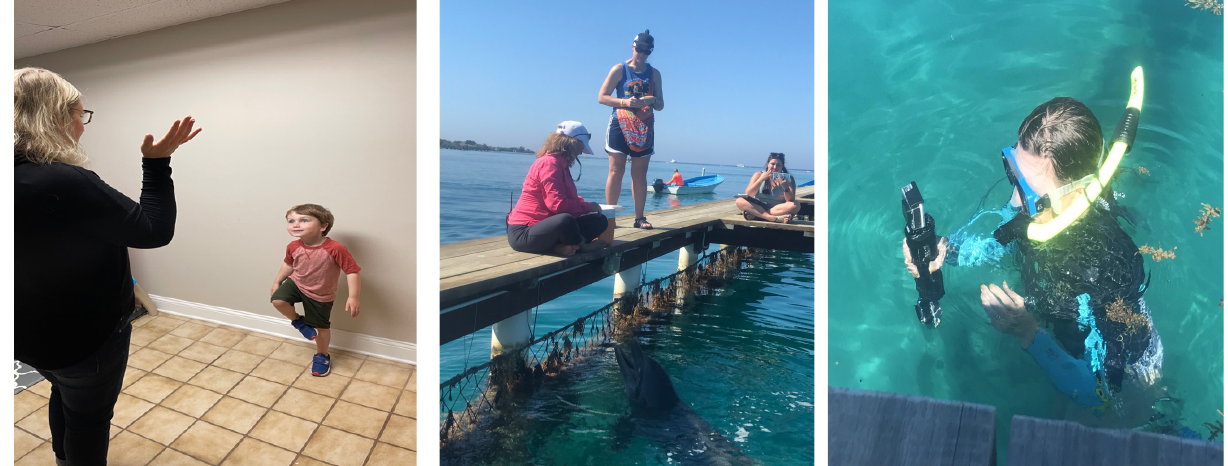
Human and Dolphin Training Procedures